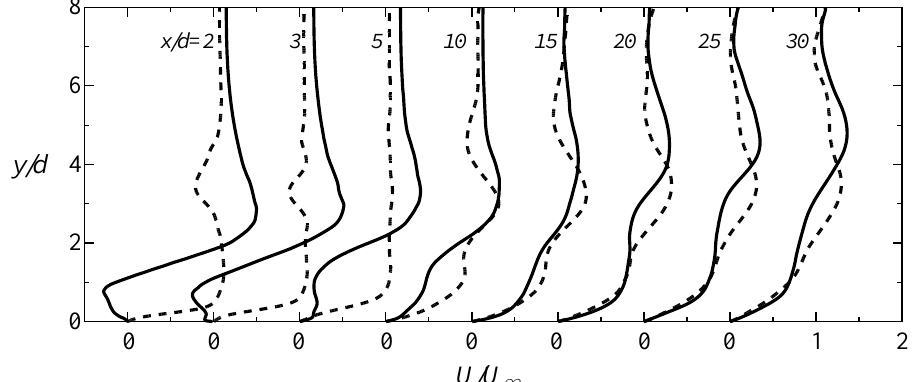
Fig. 3 Mean streamwise velocity profile. Solid line: